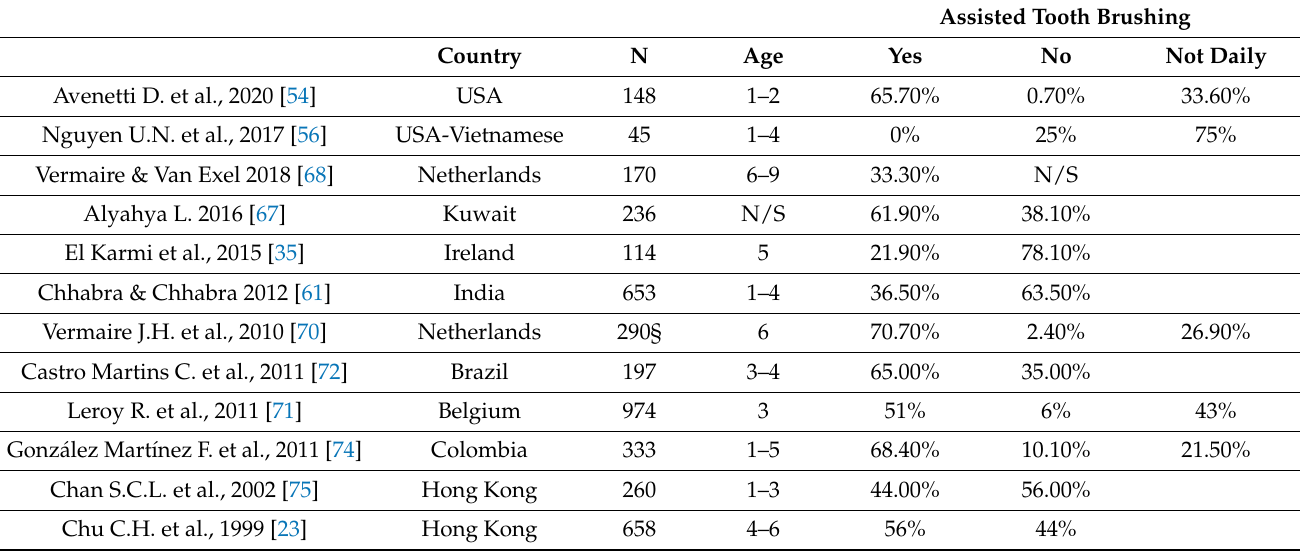
Table 3. Prevalence of assisted tooth brushing.